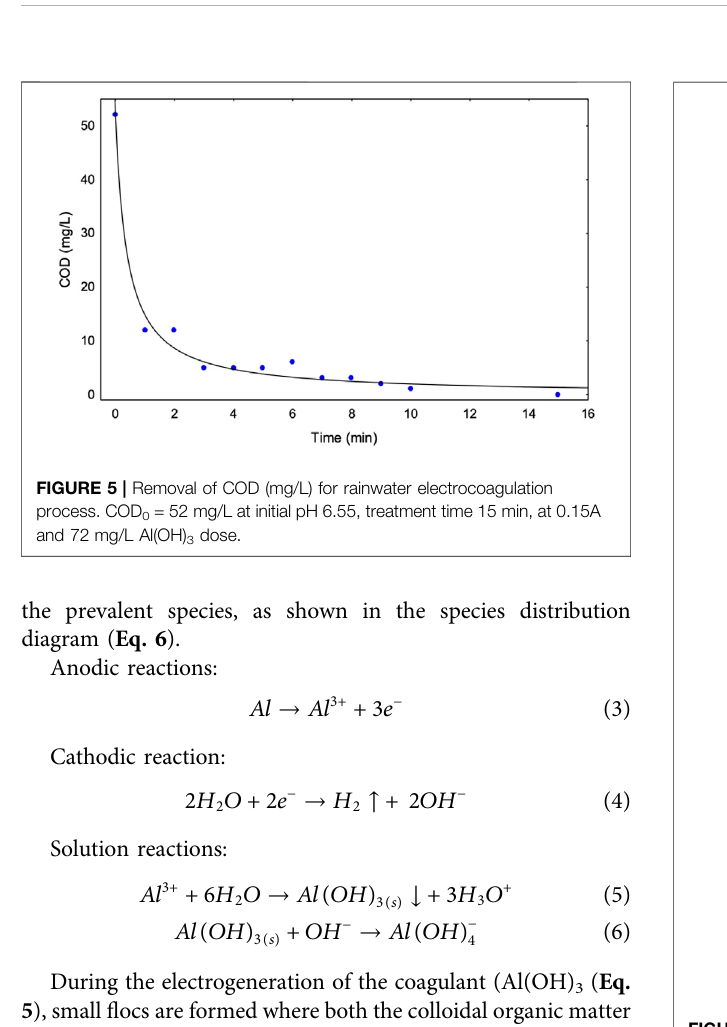
FIGURE 6 | The electrochemical reactions in the.